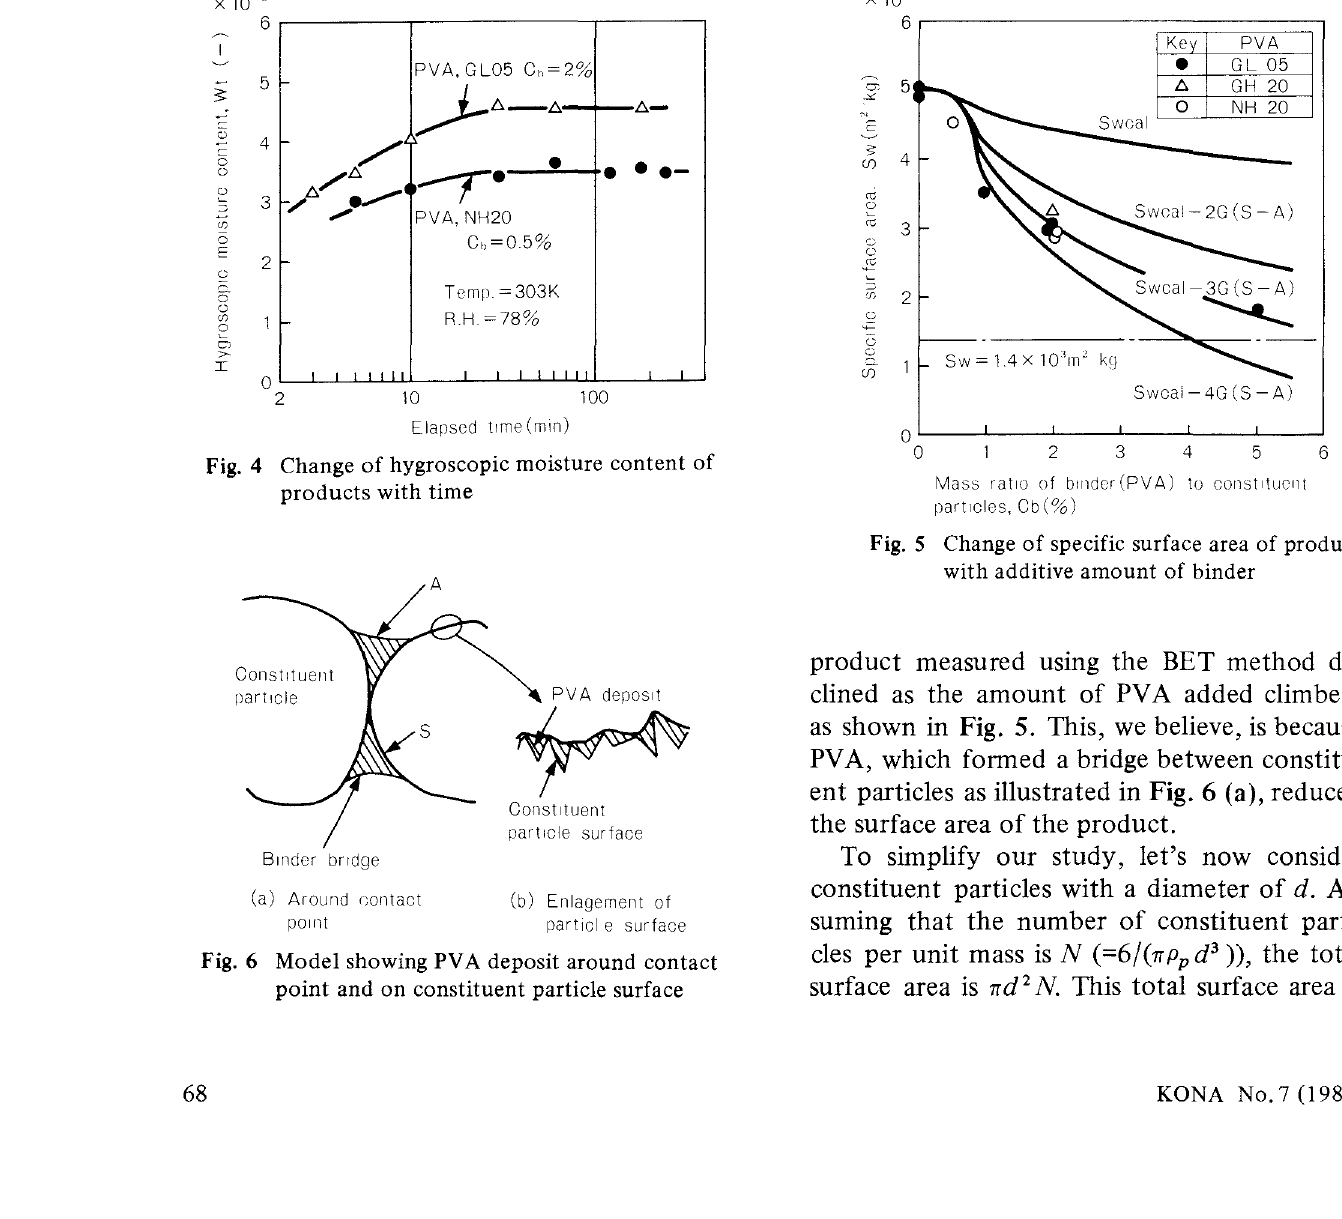
Fig. 3 Experimental apparatus for measurement of strength of products